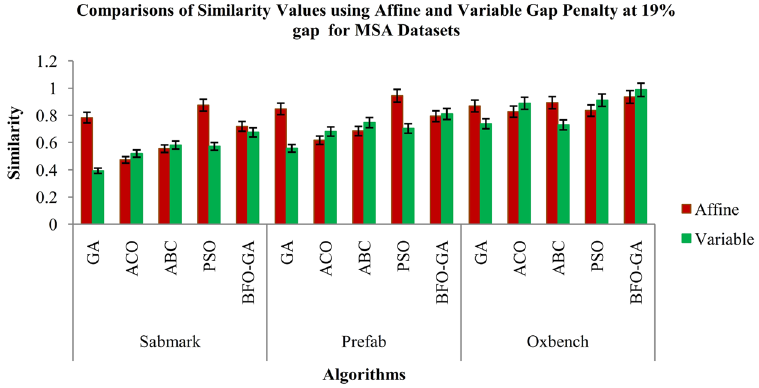
Figure 6. Comparisons of Similarity values for MSA datasets using Affine and Variable Gap penalty for proposed and existing algorithms.